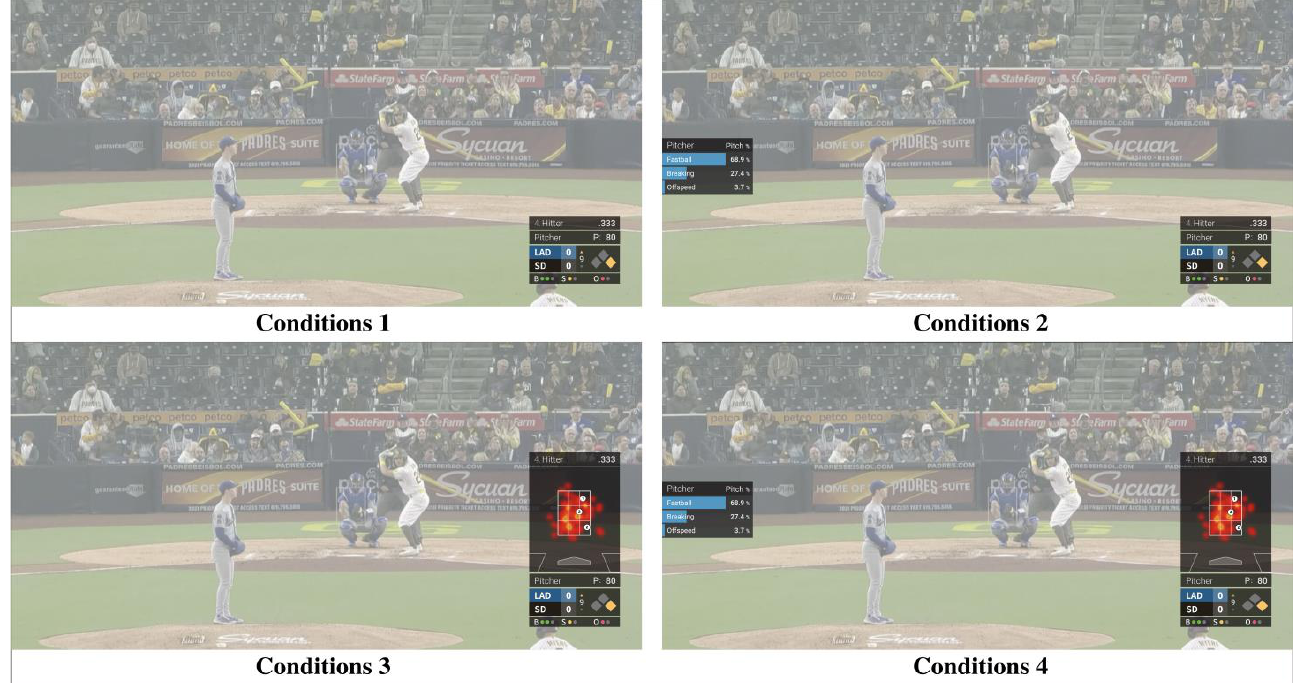
Figure 1. Contents of baseball graphical information displayed under the four conditions. “1 = control state”, “2 = information on pitcher”, “3 = information on batter”, “4 = information on both the pitcher and batter”.